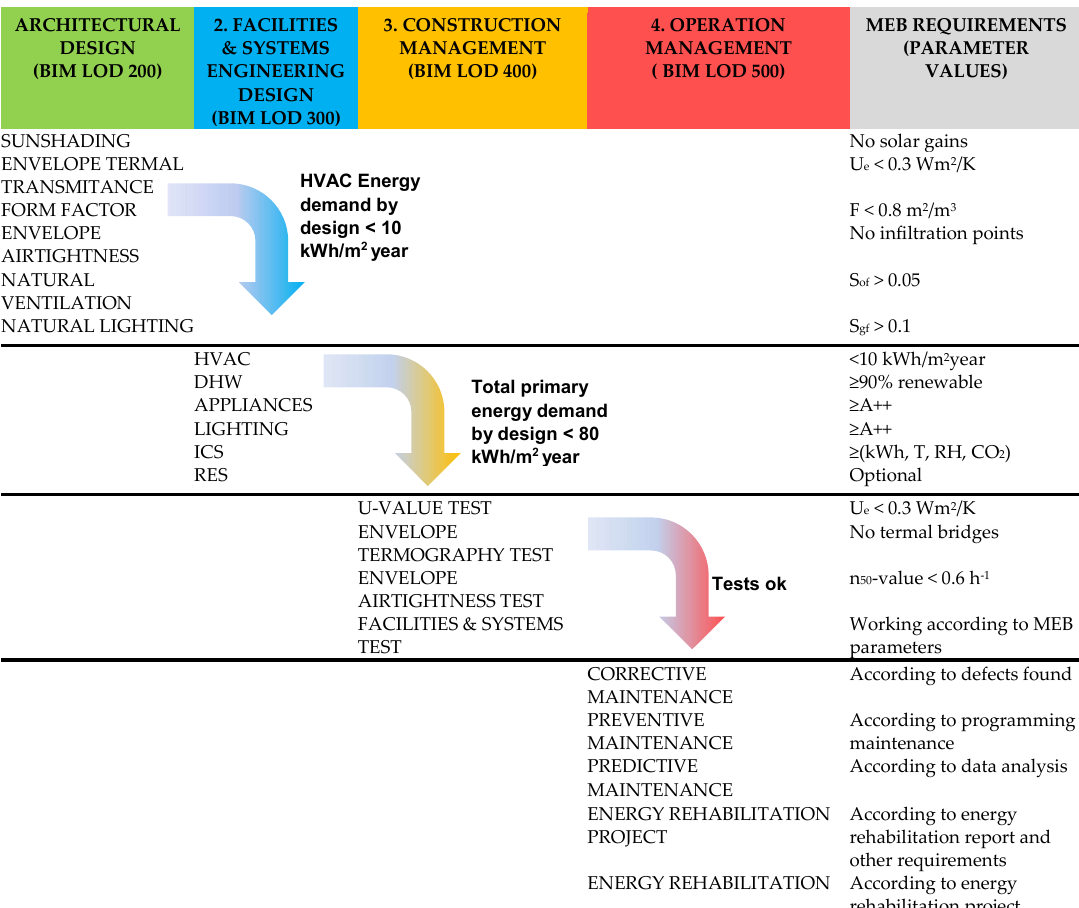
Table 1. uhuMEB methodology: MEB requirements.